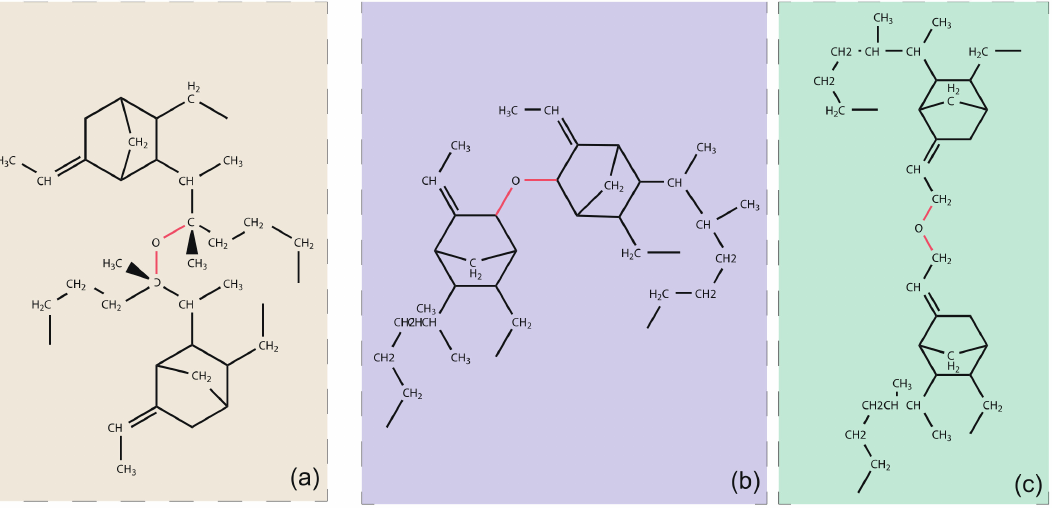
Figure 3. The possible regenerative cross-link architectures of EPDM after thermo-oxidation, ( a ) cross- linking between tertiary hydrogen carbons on the main chain, ( b ) cross-linking between two C3 atom on the side chains, ( c ) cross-linking between two C9 atoms on the side chains.